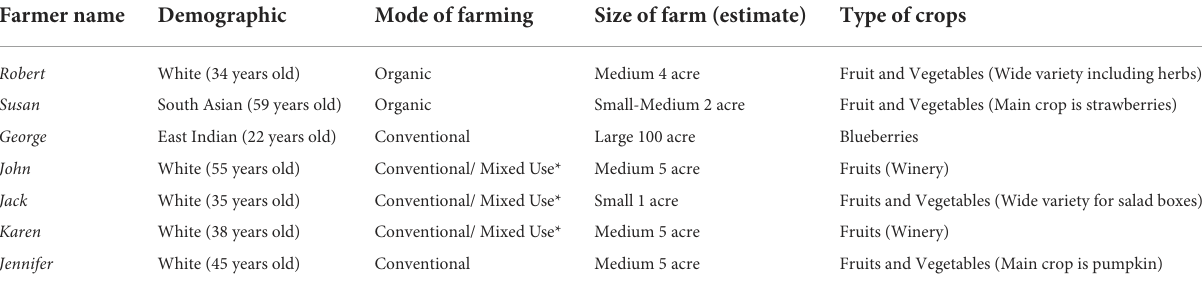
TABLE 1 Participant information table (pseudonym).